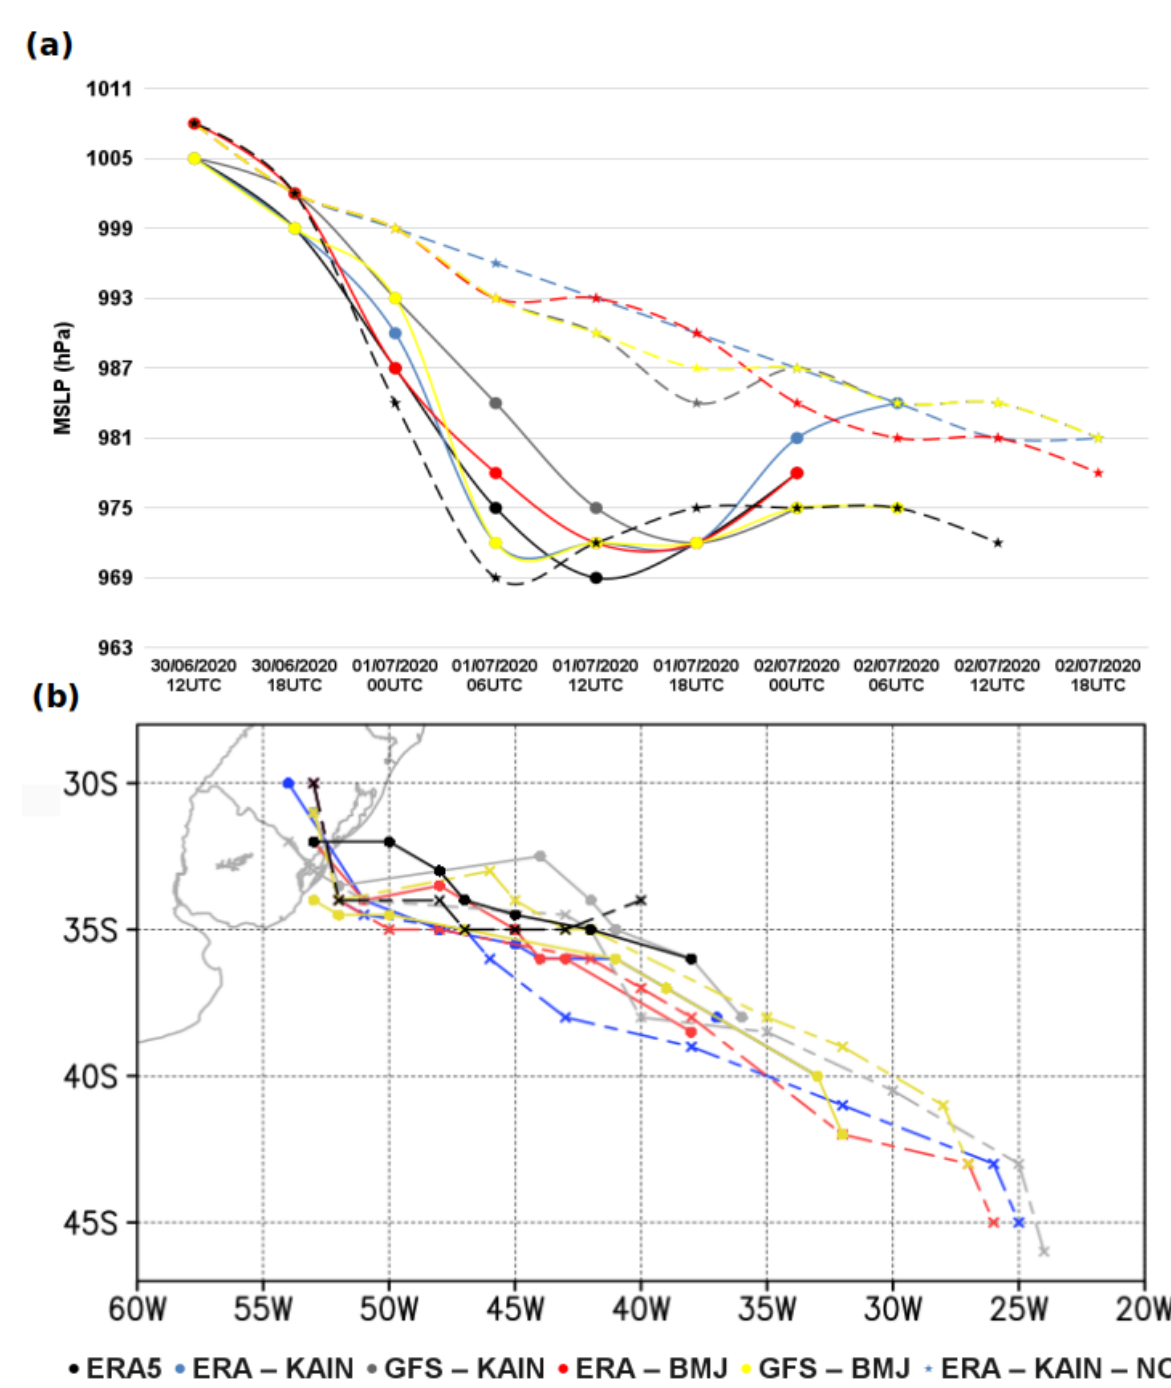
Figure 6. ( a ) Time evolution of the MSLP (hPa) at the center of the cyclone and ( b ) the trajectory between 1200 UTC 30 June to 0000 UTC 02 July 2020 for ERA5 and all experiments described in Table 2. The markers indicate the cyclone position every 6 h. The cyclogenesis occurs over the continent.